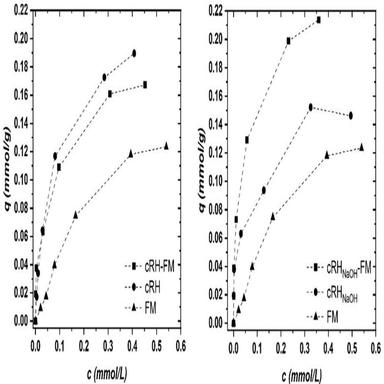
Copper ions adsorption isotherms of cRH, cRHNaOH, cRH-FM, cRHNaOH-FM and FM. (Mass of adsorbent = 20 mg, volume of aqueous model solution = 10 mL, metal ion initial concentration between 0 and 50 mg/L (0.787 mmol/L), equilibrium pH between 6 and 7, T = 20◦C). The ions concentration is affected by an error lower than 4 % while that of the adsorption capacity is lower than 6 %. Lines are guides for the eyes.